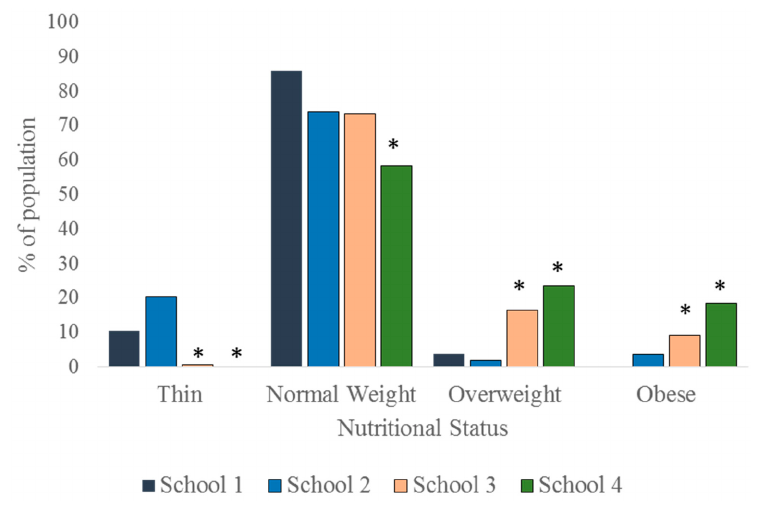
Figure 2. Nutritional status of the children, irrespective of age range and sex. *: p < 0.05.